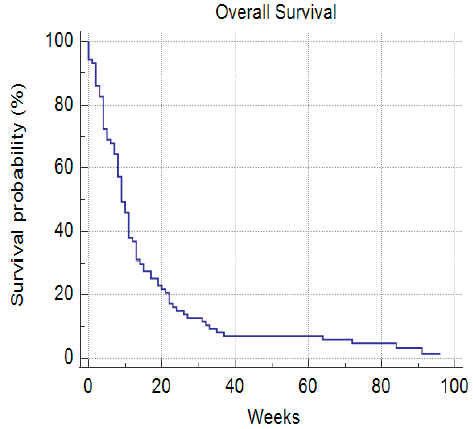
Figure 6. Median overall survival rate.